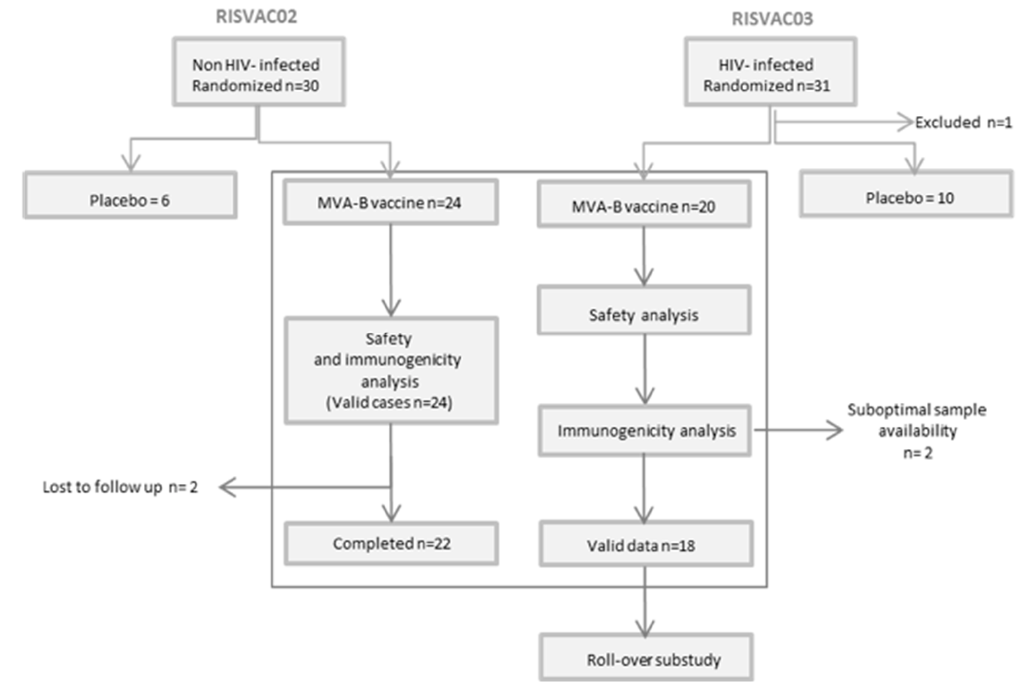
Figure 2. Patient disposition flowchart.